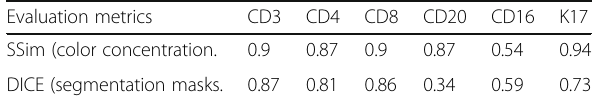
Table 1 Evaluation of ColorAE Evaluation metrics CD3 CD4 CD8 CD20 CD16 K17 SSim (color concentration. DICE (segmentation masks. 0.87